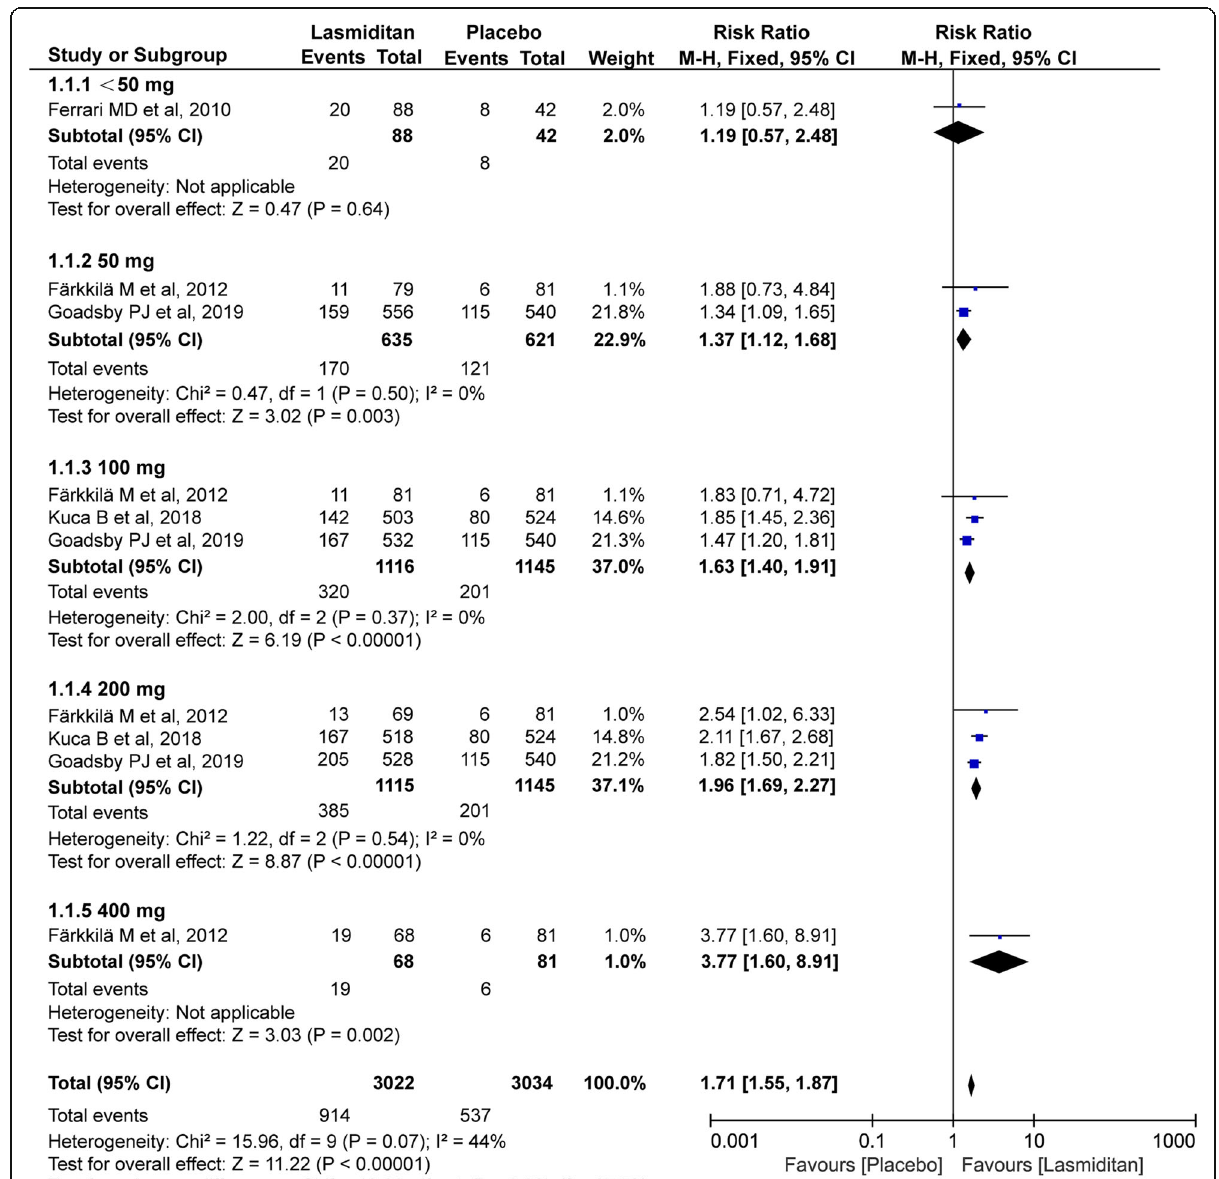
Fig. 3 Meta-analysis of the pain free at 2 h after therapy with lasmiditan compared with placebo. The diamond indicates the estimated relative risk with 95% confidence interval for the pooled patients. M-H, Mantel-Haenszel; CI, confidence